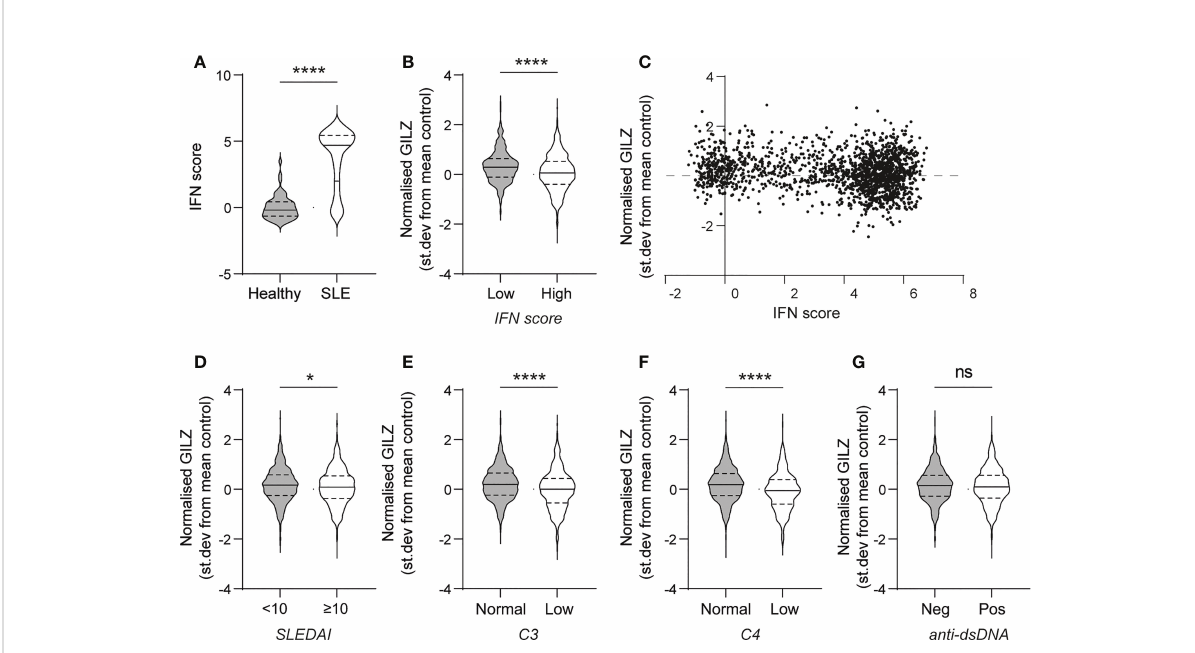
FIGURE 1 PBMC from SLE patients with high IFN score and higher disease activity express less GILZ. (A) IFN score in PBMC of healthy controls and SLE patients. (B) GILZ expression in PBMC of SLE patients with low (n=439) or high IFN (n=1317)score. (C) Correlation between IFN score (expressed as STD from mean healthy control expression level) and GILZ mRNA expression. (D – G) GILZ expression in PBMC of SLE patients, categorized by SLEDAI (D) , C3 and C4 complement activity (E – F) and anti-dsDNA status (G) . All data originated from GSE88884 (n=1,756 SLE patients, n=50 healthy controls). *p<0.05, ****p<0.0001. ns, Not signi fi